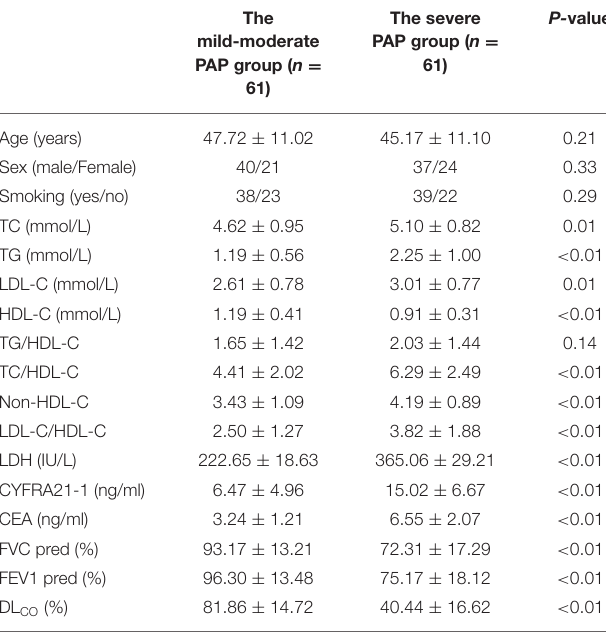
TABLE 2 | The differences of lipid ratios in different severity PAP groups.